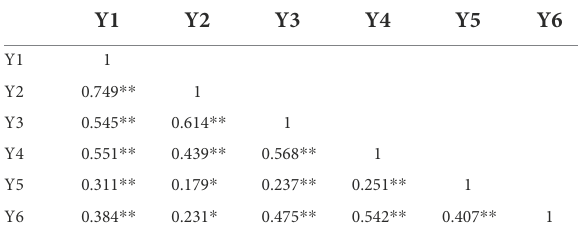
TABLE 8 Correlation results within reading test subskills.